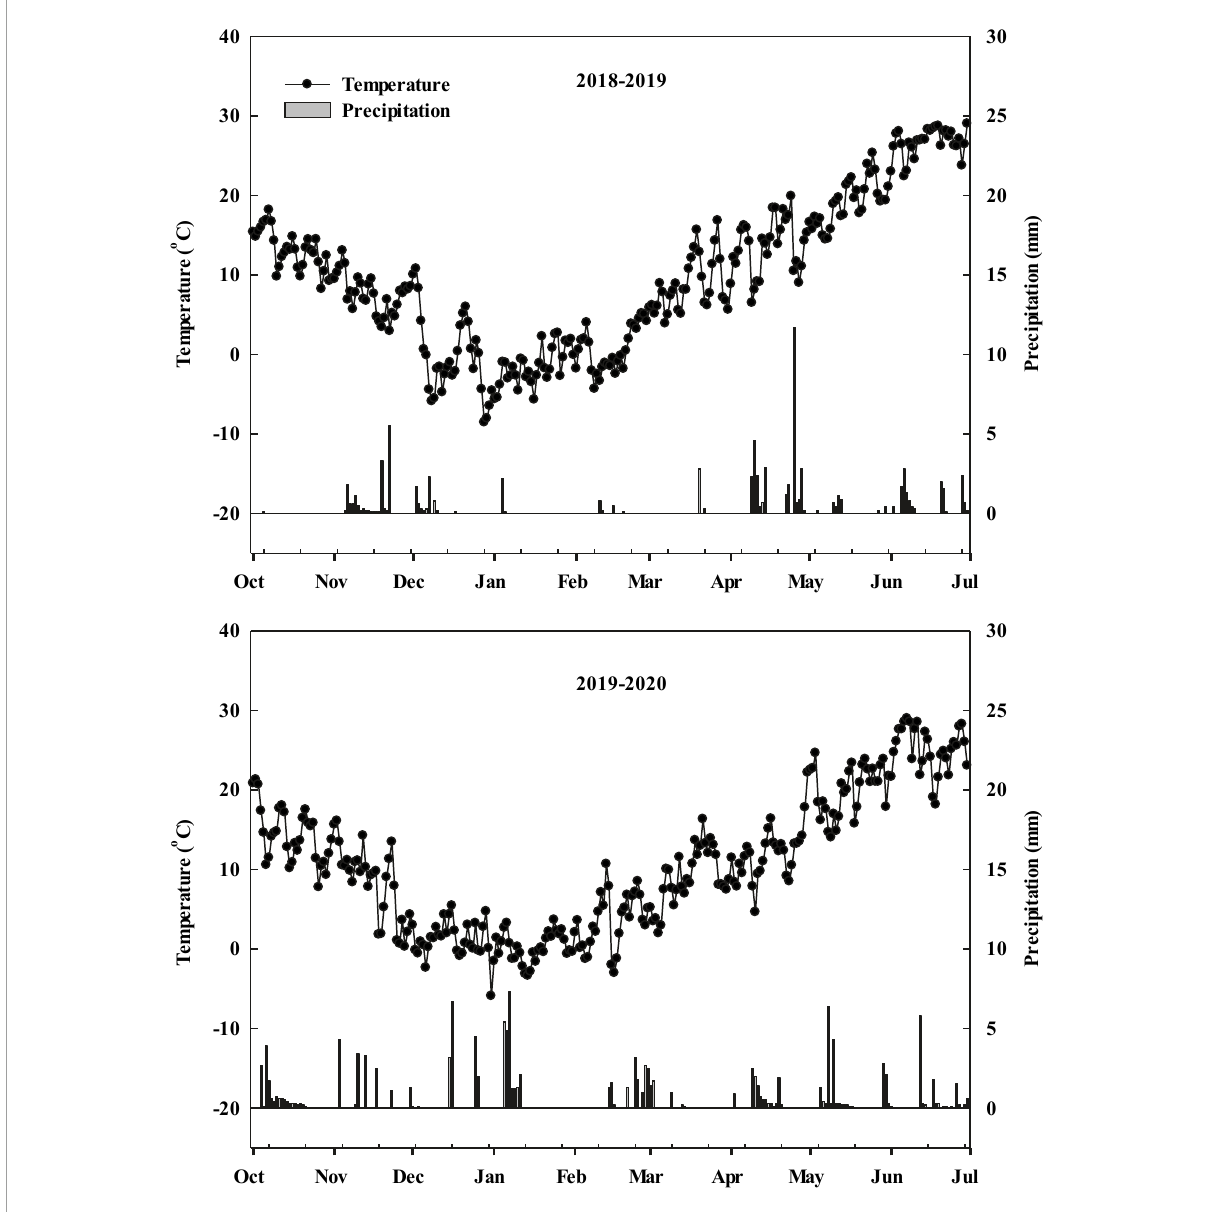
FIGURE1 Precipitation and mean temperature during the winter wheat growth period (October to the following June) in the 2018–2019 and 2019–2020 growing seasons.